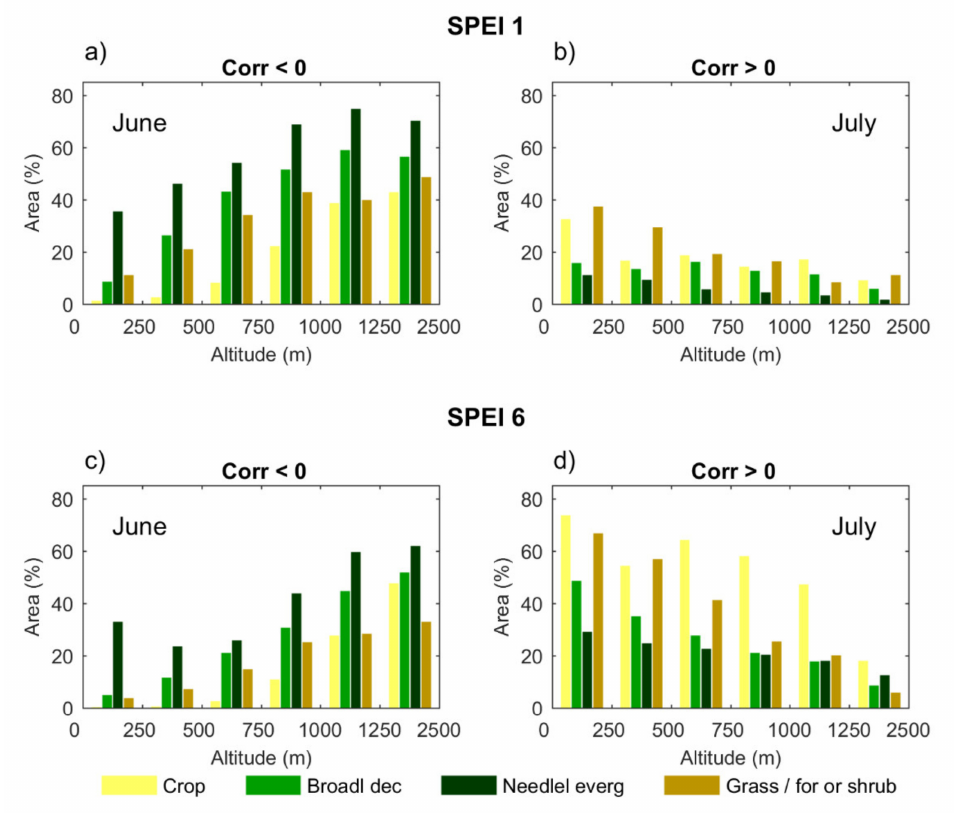
Figure 4. Percentage area showing significant: ( a ) negative correlations in June for SPEI 1; ( b ) positive correlations in July for SPEI 1; ( c ) negative correlations in June for SPEI 6; ( d ) positive correlations in July for SPEI 6.